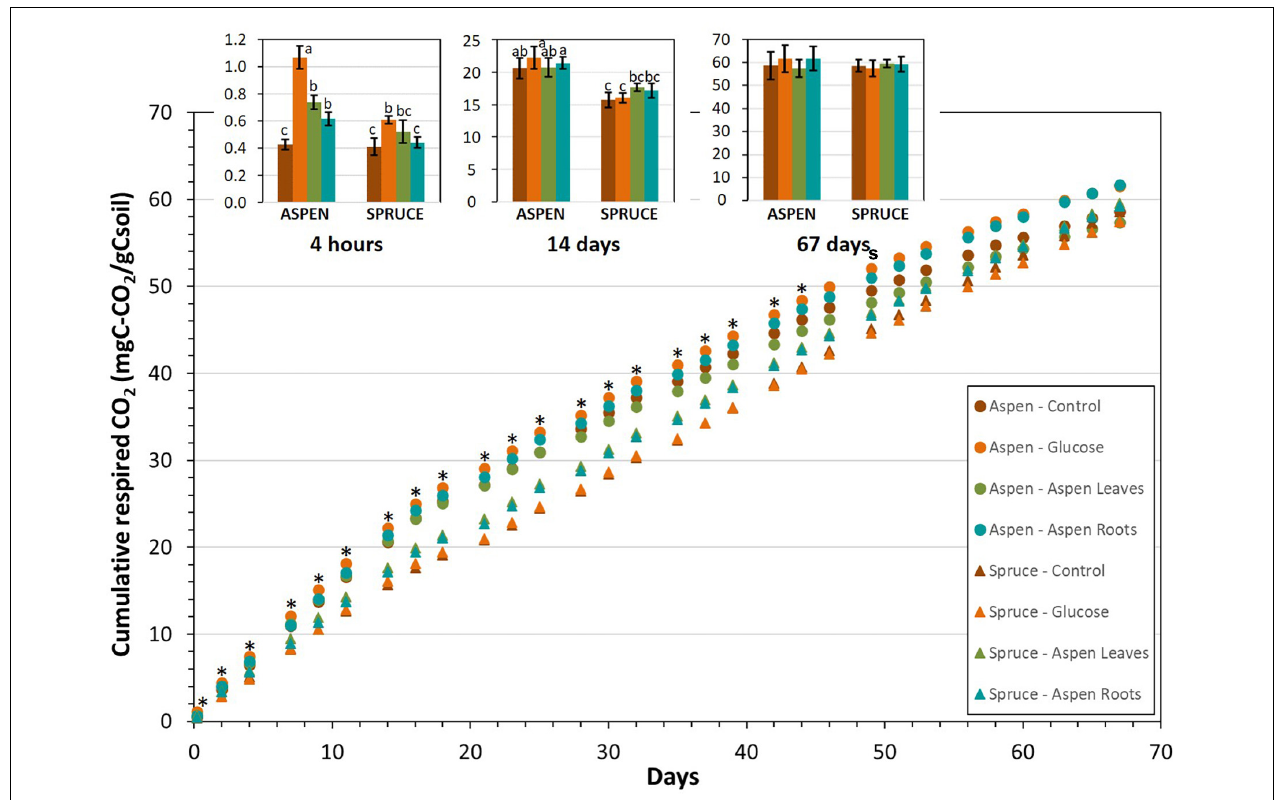
FIGURE 1 | Average cumulative respired C-CO 2 from the aspen (circles) and spruce (triangles) soil incubation units for all substrates (glucose, aspen leaves and aspen roots) during the 67-day laboratory incubation. Asterisks indicate dates where statistical differences among samples were detected using a one-way ANOVA. In addition, the inset bar graph shows average cumulative respired CO 2 from the aspen and spruce soil incubation units at three dates (4 h, 14 days, and 67 days), with error bars showing standard deviations over five replicates and different letters indicating significant differences ( p <